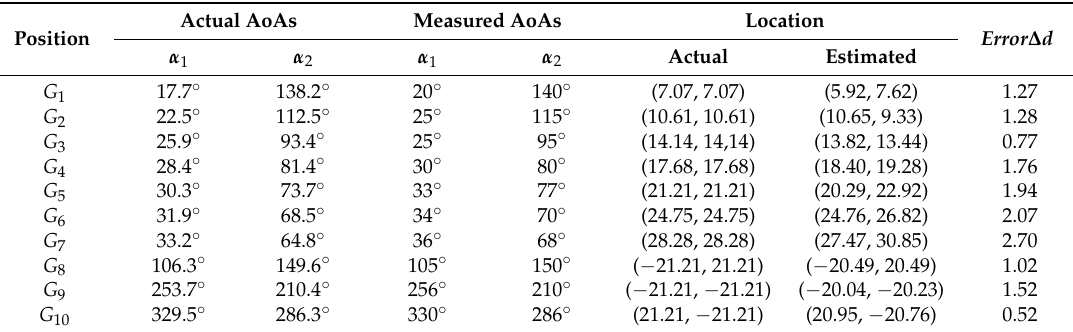
Figure 7. Indoor localization errors. Table 1. Indoor localization